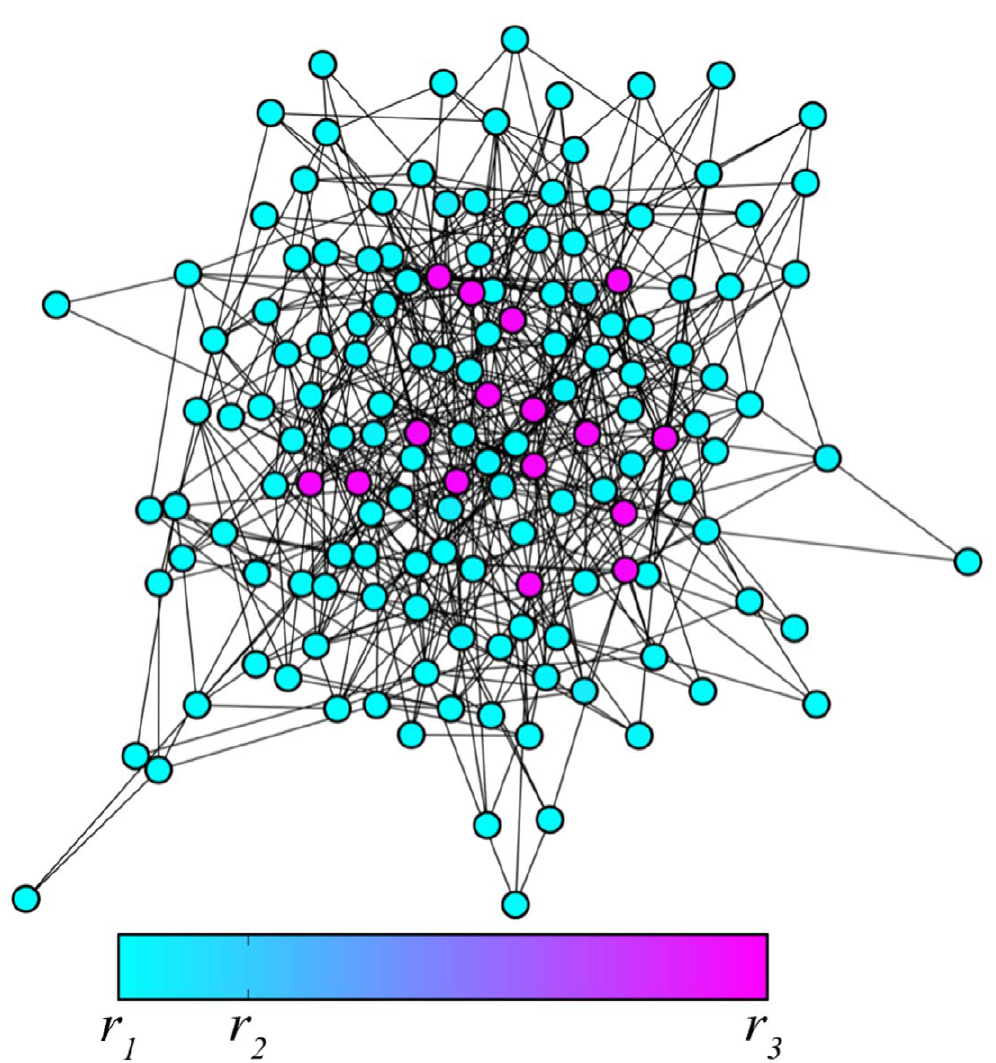
Figure 2. Stationary pattern in an Erdo¨s-Re´nyi network. The network size is N ~ 150 and the mean degree is S k T ~ 7 . The nodes with higher degrees are located closer to the center. The nodes are colored according to their activation level, as indicated in the bar. The other parameters are r 1 ~ 1 , r 2 ~ 1 : 4 and r 3 ~ 3 ; the diffusion constant is D ~ 0 : 01 .